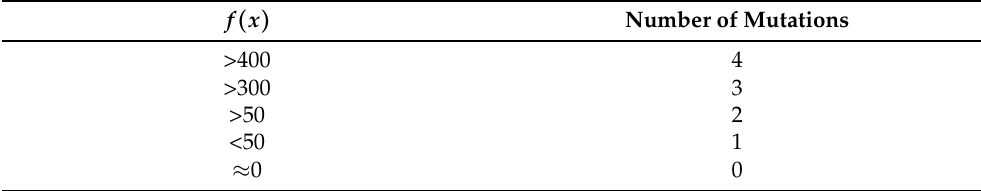
Table 2. Number of mutations according to the feasibility function of the operating